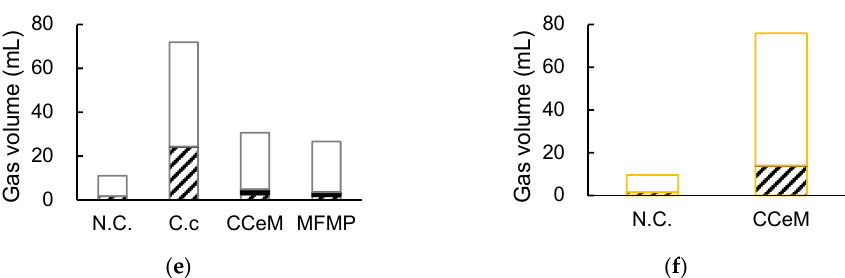
Figure 3. Cultivation of C. cellulovorans , cellobiose and MFMP (CCeM) and microbial flora of methane production (MFMP) with Avicel. ( a ) Cell growth, where C. cellulovorans ( ○ _open circle), CCeM ( ● _closed circle) and MFMP ( Δ _open triangle) are included; ( c ) total sugar concentration; ( e ) gas production of H 2 (hatched bar), CH 4 (closed bar), and CO 2 (open bar) are included. Cultivation of C. cellulovorans , CCeM, and MFMP with removed peel. ( b ) Cell growth, where C. cellulovorans ( ○ _open circle), CCeM ( ● _closed circle), and MFMP ( Δ _open triangle) are included; ( d ) total sugar concentration; ( f ) gas production of H 2 (hatched bar), CH 4 (closed bar), and CO 2 (open bar) are included. Values with error bars are mean ± SE of three independent samples. SE means a standard error. An asterisk indicates a significant difference ( p < 0.05).